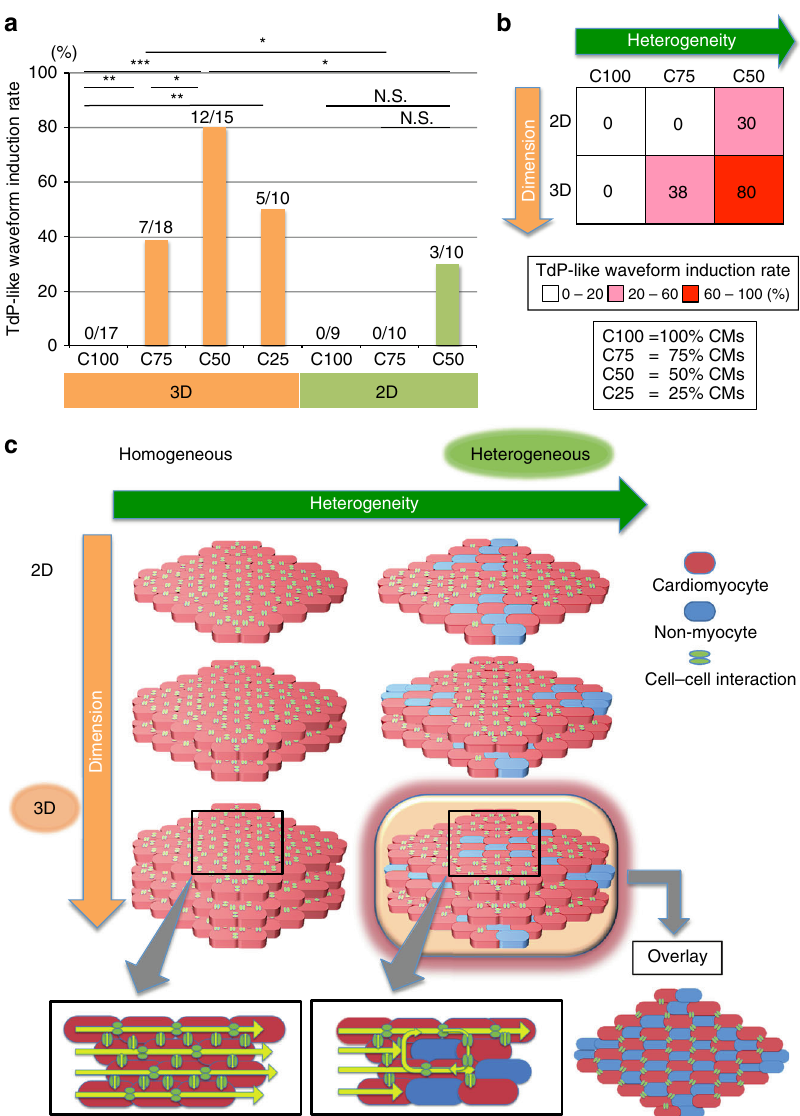
Fig. 5 Sine qua non for TdP generation in vitro. a Induction rates of TdP-like waveform in CTSs of different heterogeneities and dimensions. C100, cells or sheets with 100% cardiomyocytes. C75, cells or sheets with 75% cardiomyocytes. C50, cells or sheets with 50% cardiomyocytes. C25, sheets with 25% cardiomyocytes. CMs, cardiomyocytes. Fisher ’ s exact test * p < 0.05, ** p < 0.01 and *** p < 0.001. b Relationship of TdP-like waveform incidence with cell heterogeneity and dimension. c A putative mechanism for the emergence of TdP. Heterogeneity and dimension enhance the initiation of micro re-entry events and the maintenance of meandering spiral wave centers, respectively, in CTSs. Cellular heterogeneity hampers electrical conduction and detours the propagation direction. The 3D structure eliminates the coarse structures that are present in 2D layers and provides appropriate heterogeneity for a functional center of spiral wave